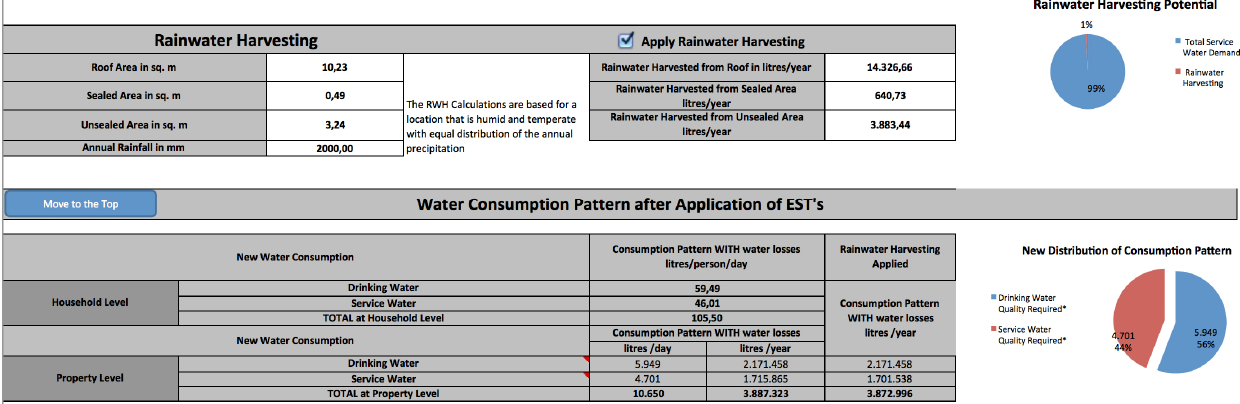
Figure 8. User interface of the “Water Consumption after EST” sheet in “Wise